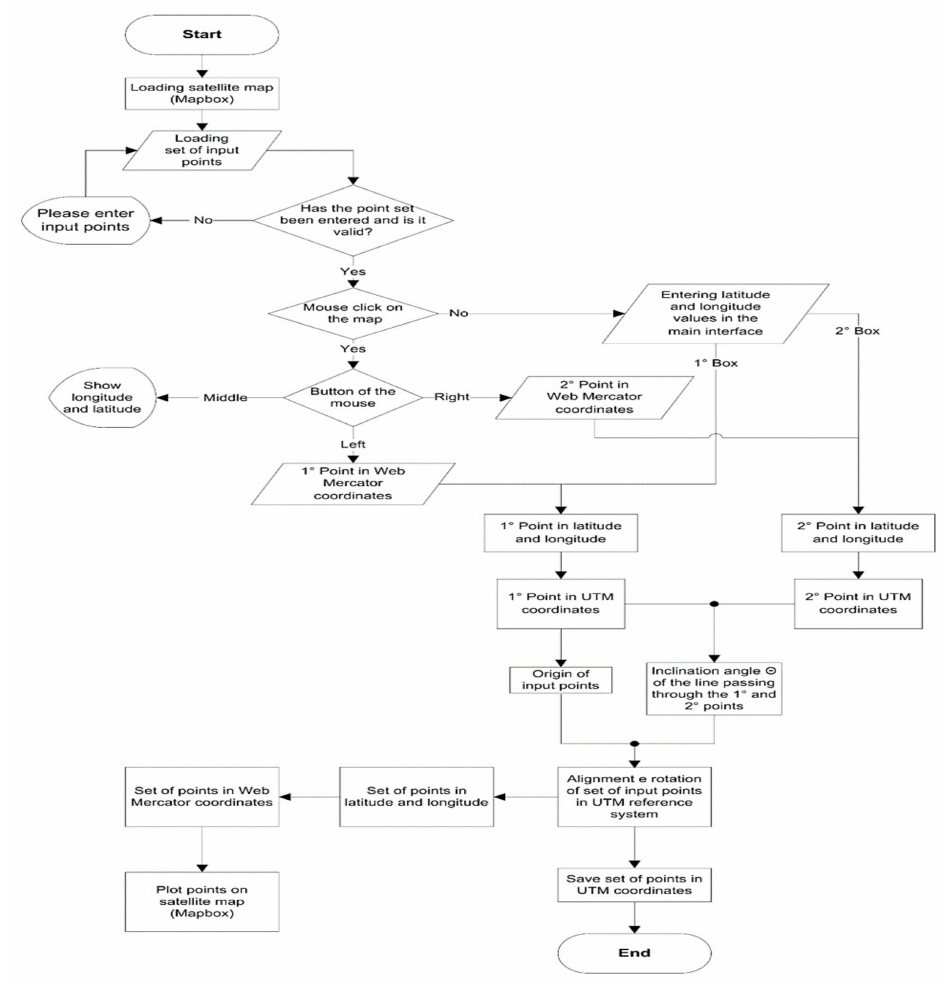
Figure 12. Flow chart of the script related to the Matlab Mapbox